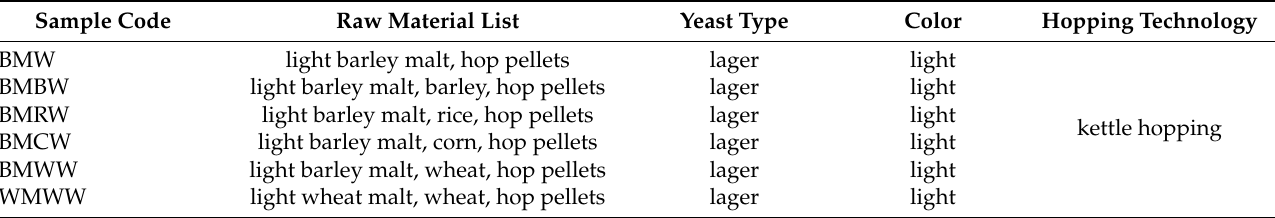
Table 14. The beer samples